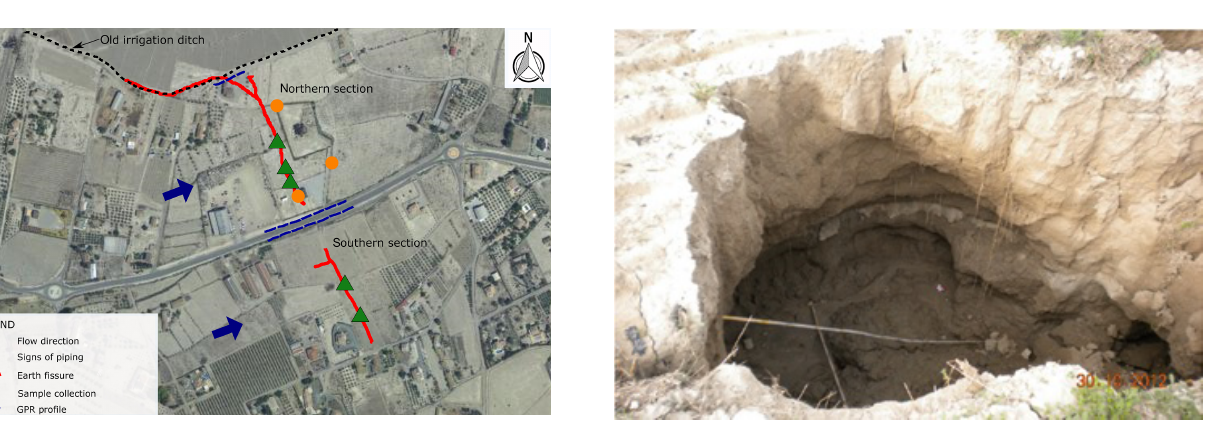
Figure 2. Signs of piping along the fissure. Soil erosion caused by water beneath the surface of the ground creating an underground